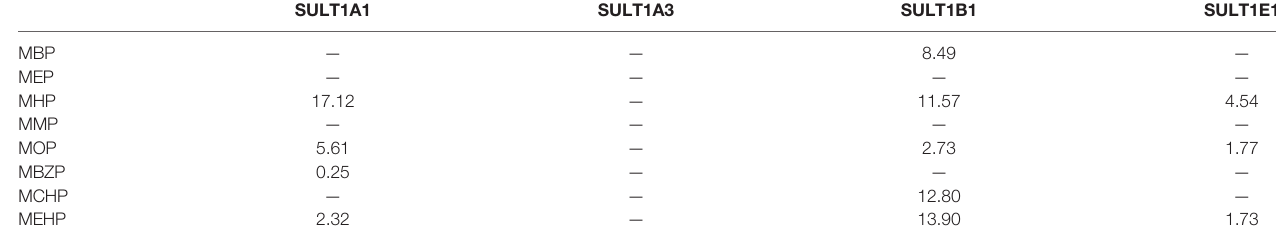
TABLE 1 | Half inhibition concentrations (IC50) of phthalate monoesters towards SULTs isoforms.